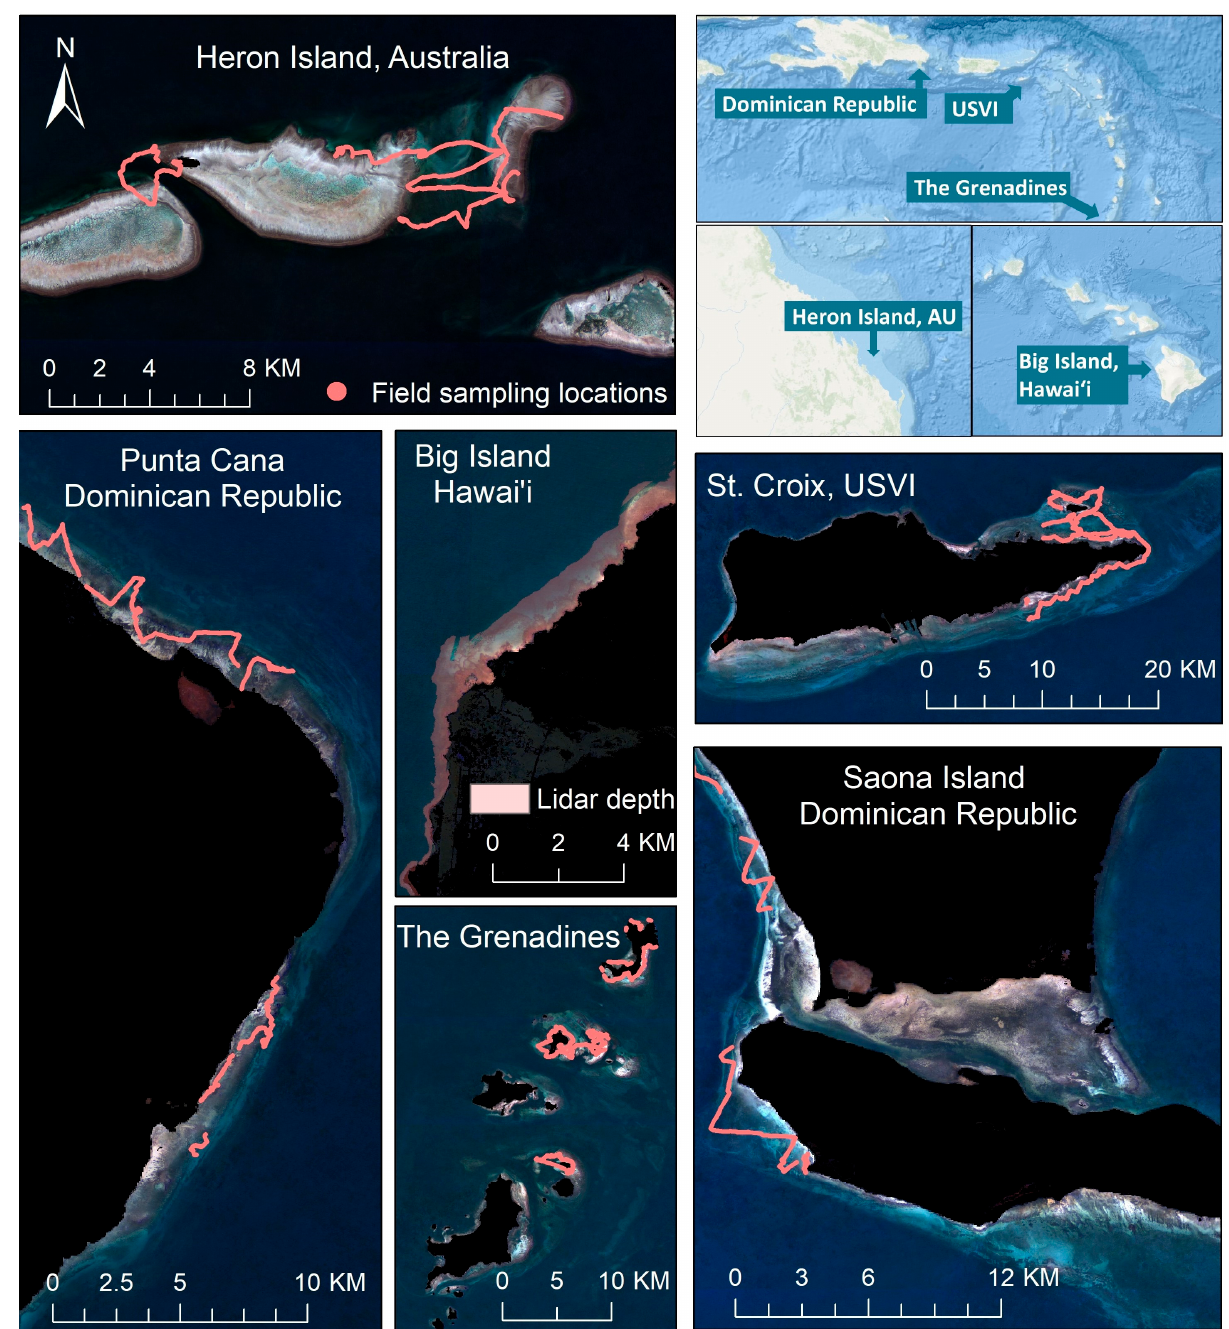
Figure 1. Sentinel-2 true color mosaics (i.e., 12-month mosaic) and field sample locations for the six study sites. We used lidar-derived bathymetry in the Big Island, Hawai’i (plotted in pink polygon). Other bathymetry samplings were measured at consecutive points.